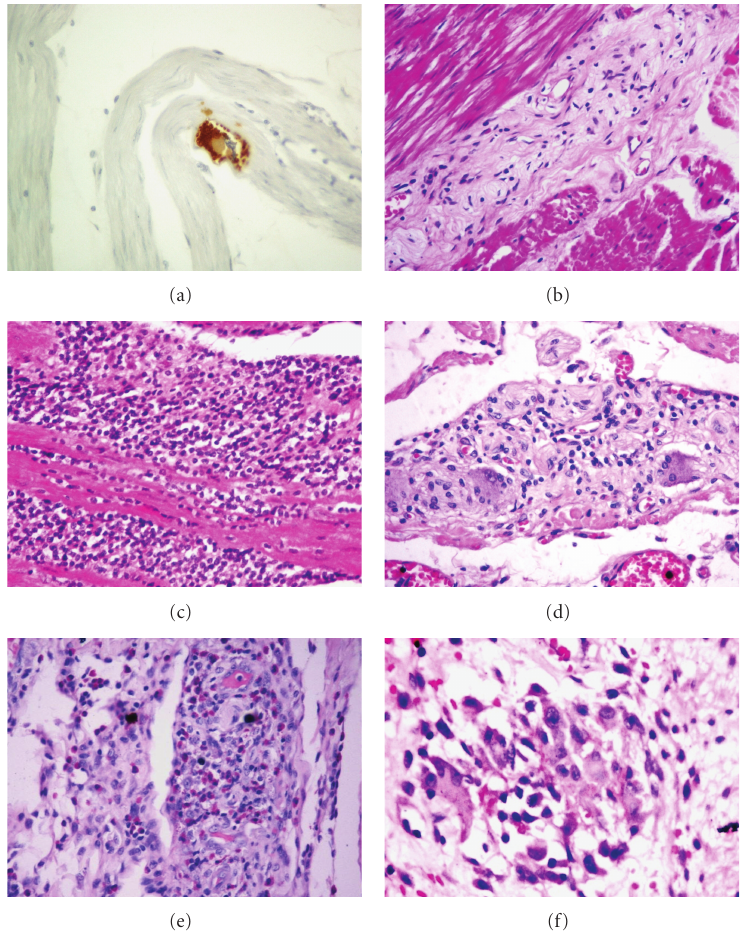
Figure 1: (a) Amastigotes forms of T. cruzi in muscular in case of megaesophagus (immunohistochemistry for T. cruzi —400x). (b) Aganglionosis and fibrosis in myenteric plexus in case of megaesophagus (HE—200x). (c) Severe chronic myositis in a case of megaesophagus (HE—400x). (d) Mild chronic ganglionitis in esophagus without mega (HE—400x). (e) Severe chronic ganglionitis surrounded by eosinophils in a case of megaesophagus (Giemsa—400x). (f) Myositis with granuloma in a case of megacolon